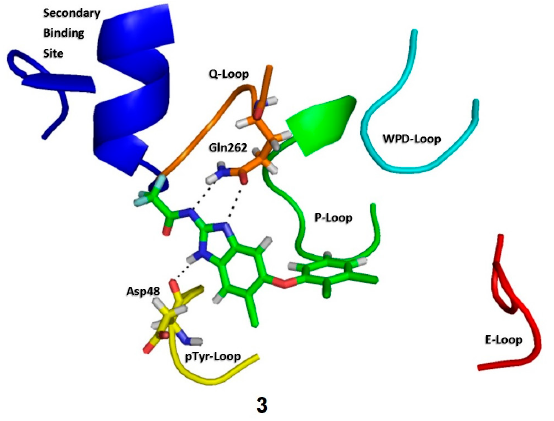
Figure 3. Binding mode of compounds 1 , 2 and 3 in PTP1B. Loops are highlighted as follows: P loop (green), WPD loop (cyan), Q262 loop (orange), pTyr46 loop (yellow), and E loop (red). Secondary phosphate binding site is highlighted in blue.